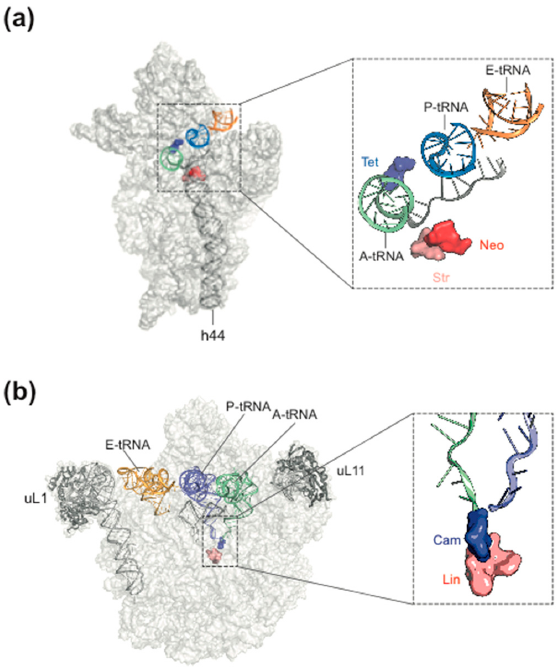
Figure 1. Antibiotic target sites of bacterial ribosomes. ( a ) a few antibiotic target sites on the 30S subunit mentioned in the text. Tet, tetracycline; Neo, neomycin, Str, streptomycin; ( b ) some antibiotic target sites on the 50S subunit. Cam, chloramphenicol; Lin, lincomycin. (from [7], modified, courtesy of Daniel N. Wilson, Munich Gene Center).